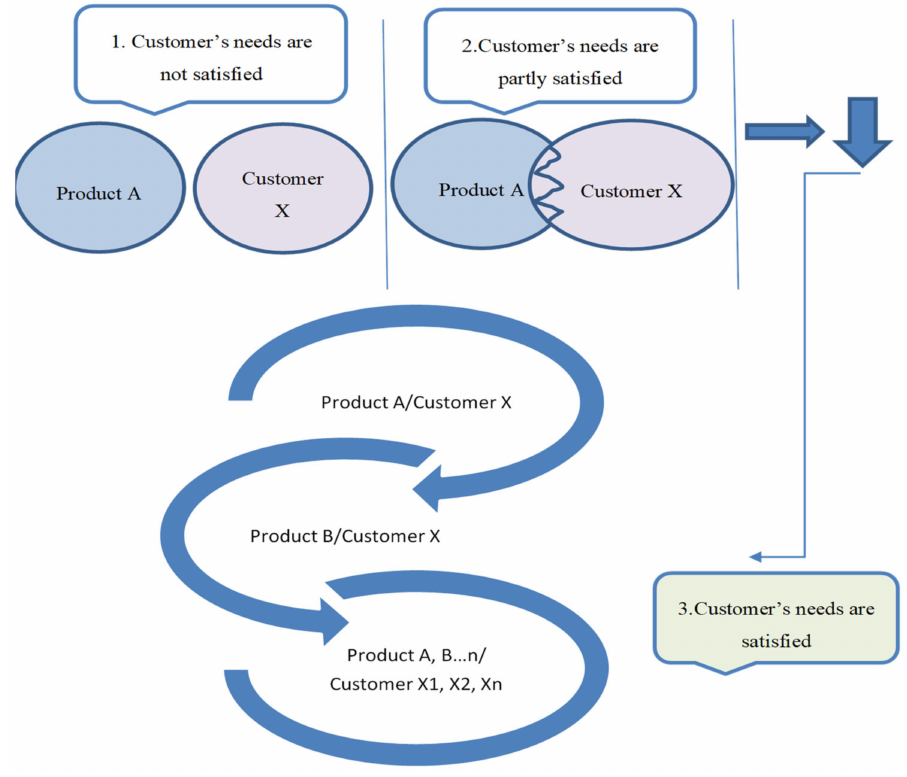
Figure 5. Three degrees of customer’s